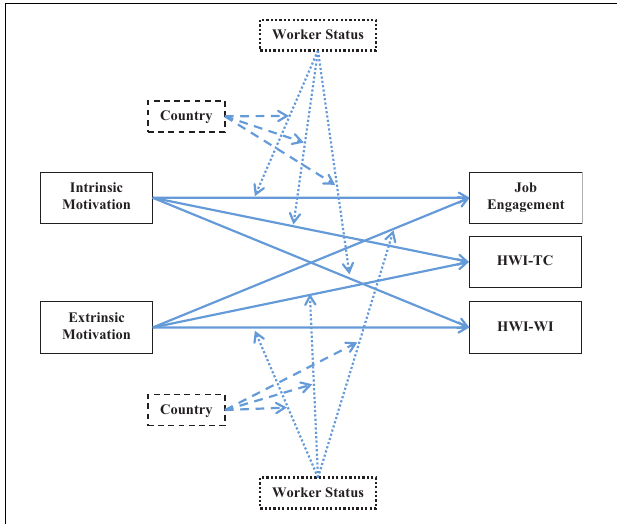
FIGURE 1 | Research model. Worker’s status: 1 = working students, 2 = non-student employees. Country: 1 = Israel, 2 = Japan. HWI-TC = time commitment dimension of heavy work investment. HWI-WI = work intensity dimension of heavy work